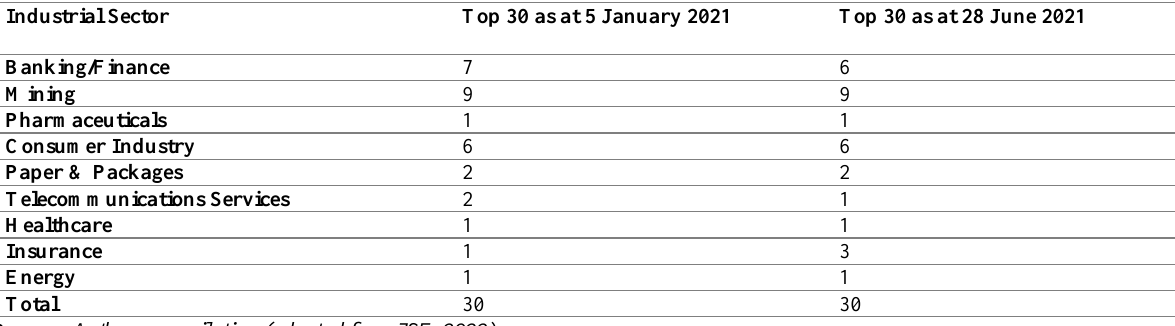
Table 1: Top 30 listed on FTSE/JSE for January and June